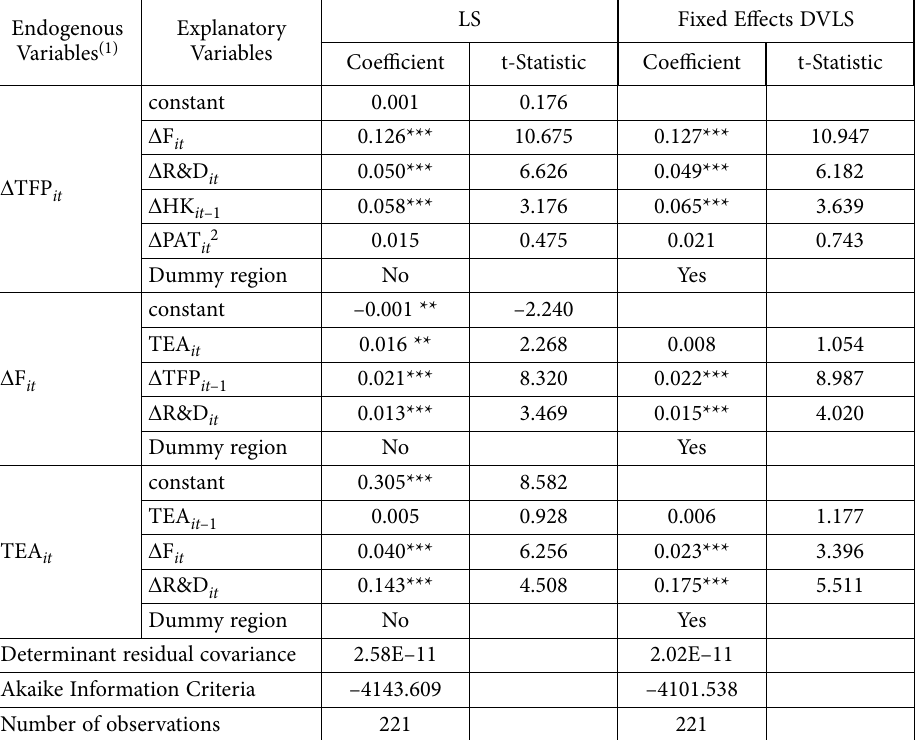
Table 2. Results of the multi-equation model by LS and